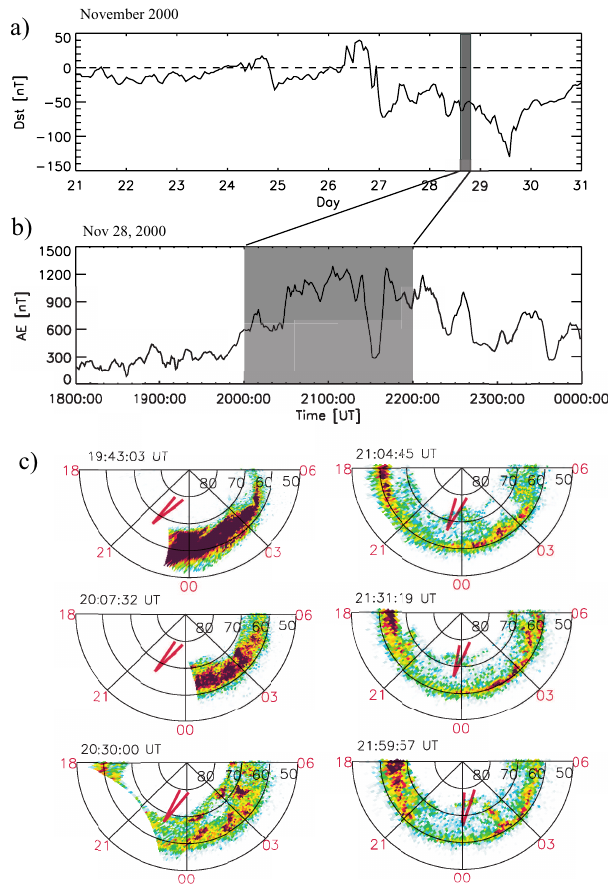
Fig. 4. The Dst ( a ) and AE ( b ) indices prior to and during the substorm on 28 November 2000. The time interval for the analysis is shown by the grey shaded areas. ( c ) The substorm development as imaged by the SI13 channel (135.6nm) of the Spectrographic Imager. Red lines indicate the line of sight of the two beams of the EISCAT VHF